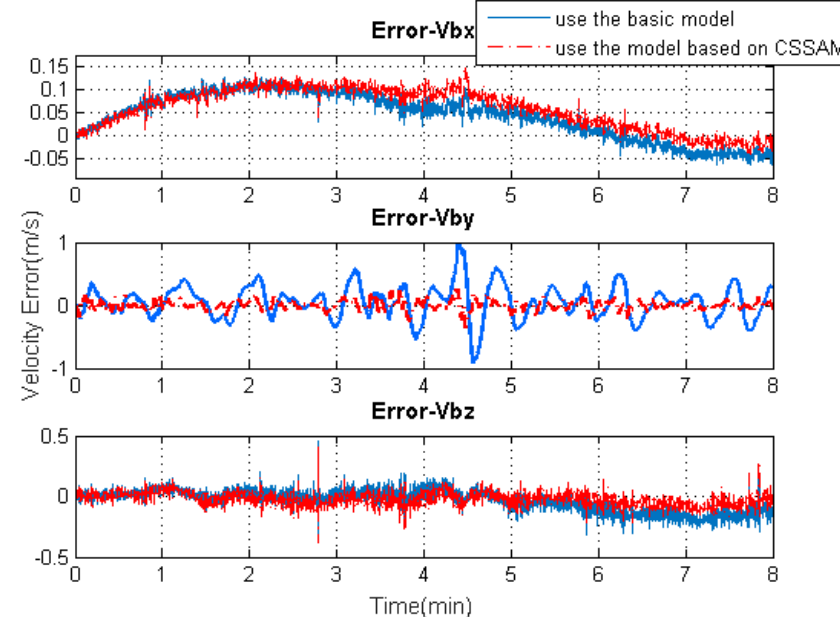
Figure 10. The 3D velocity solution accuracy comparisons using the basic model or the model based on the CSSAM.